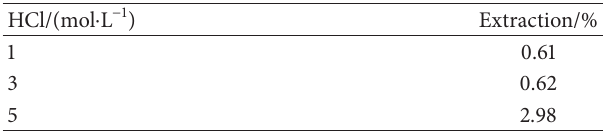
Figure 1: Effect of different concentrations of HCl and H 2 SO 4 on Te(IV) extraction. Table 1: Effect of HCl concentration on Te(VI)